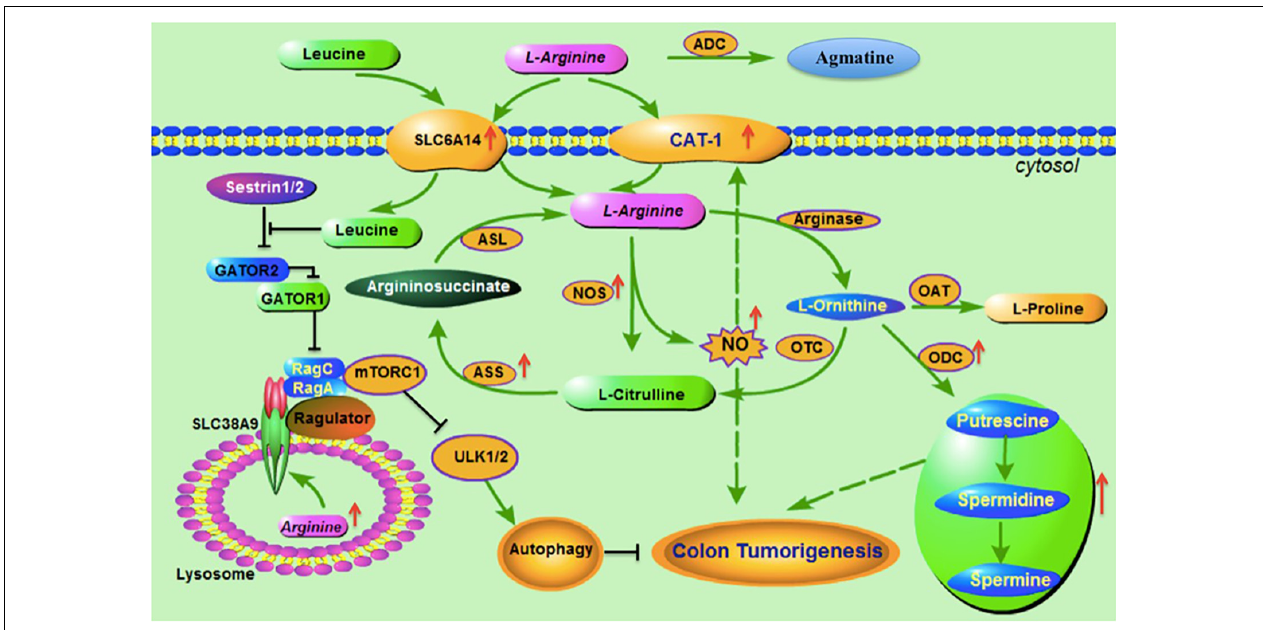
FIGURE 1 | Arginine metabolic pathways and association with colorectal cancer. Before L-arginine enters into cells, arginine decarboxylase (ADC) catalyzes the arginine to generate agmatine. Arginine transporters SLC7A1 (CAT-1) and SLC6A14 are the main transporters responsible for arginine transmembrane transportation. Both CAT-1 and SLC6A14 are highly expressed in colorectal cancer. SLC6A14 is also responsible for transportation of leucine. Nitric oxide synthase (NOS) catalyzes the cytosol L-arginine to generate L-citrulline and Nitric oxide (NO), and the latter is reported to upregulate CAT-1 expression. L-citrulline is converted into argininosuccinate via Argininosuccinate synthetase (ASS), which is a rate-limiting enzyme in arginine recycle biosynthesis. Argininosuccinate lyase (ASL) catalyzes argininosuccinate to produce endogenic L-arginine. Arginase catalyzes the L-arginine to generate L-ornithine, which has three metabolic pathays: (1) converting to L- citrulline via Ornithine transcarbamylase (OTC); (2) to generate L-proline via Ornithine aminotransferase (OAT); and (3) to produce polyamines (including putrescine, spermidine and spermine) via ornithine decarboxylase (ODC). NOS, polyamines and ODC are all reported upregulated in colorectal cancer and contributing to colon tumorigenesis. SLC38A9 is a component of the lysosomal arginine sensing machinery and sestrin1/2 is the sensor of cytosol leucine, both of which control mTORC1 and regulate autophagy and involve colon